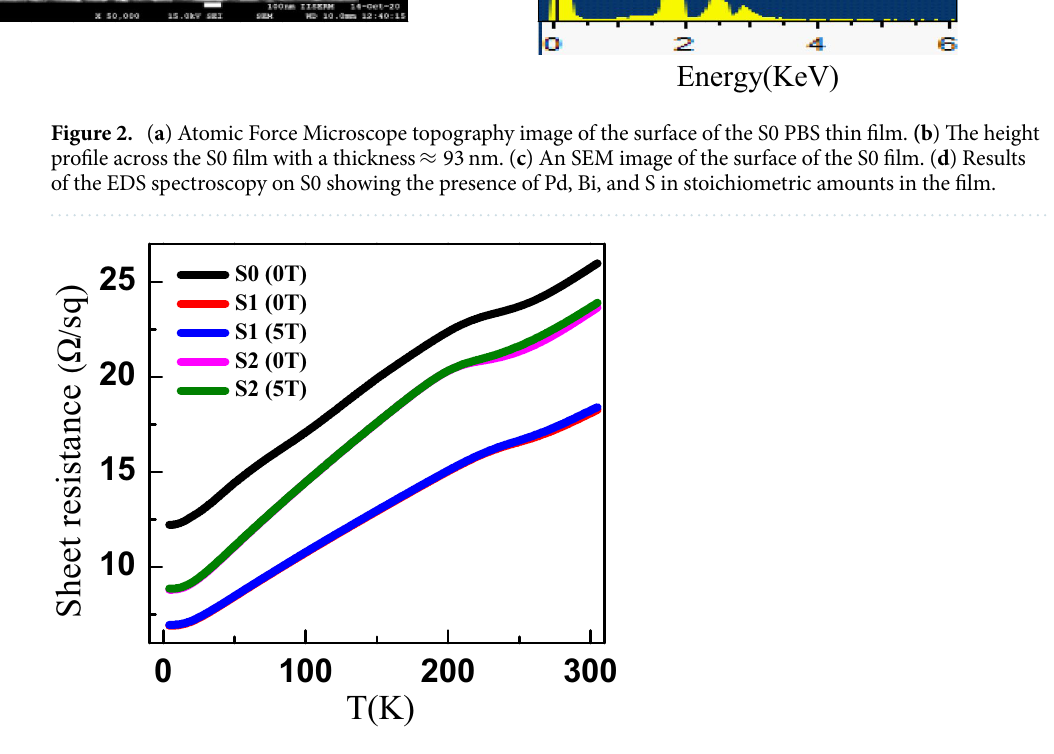
Figure 3. Sheet resistance vs temperature at B